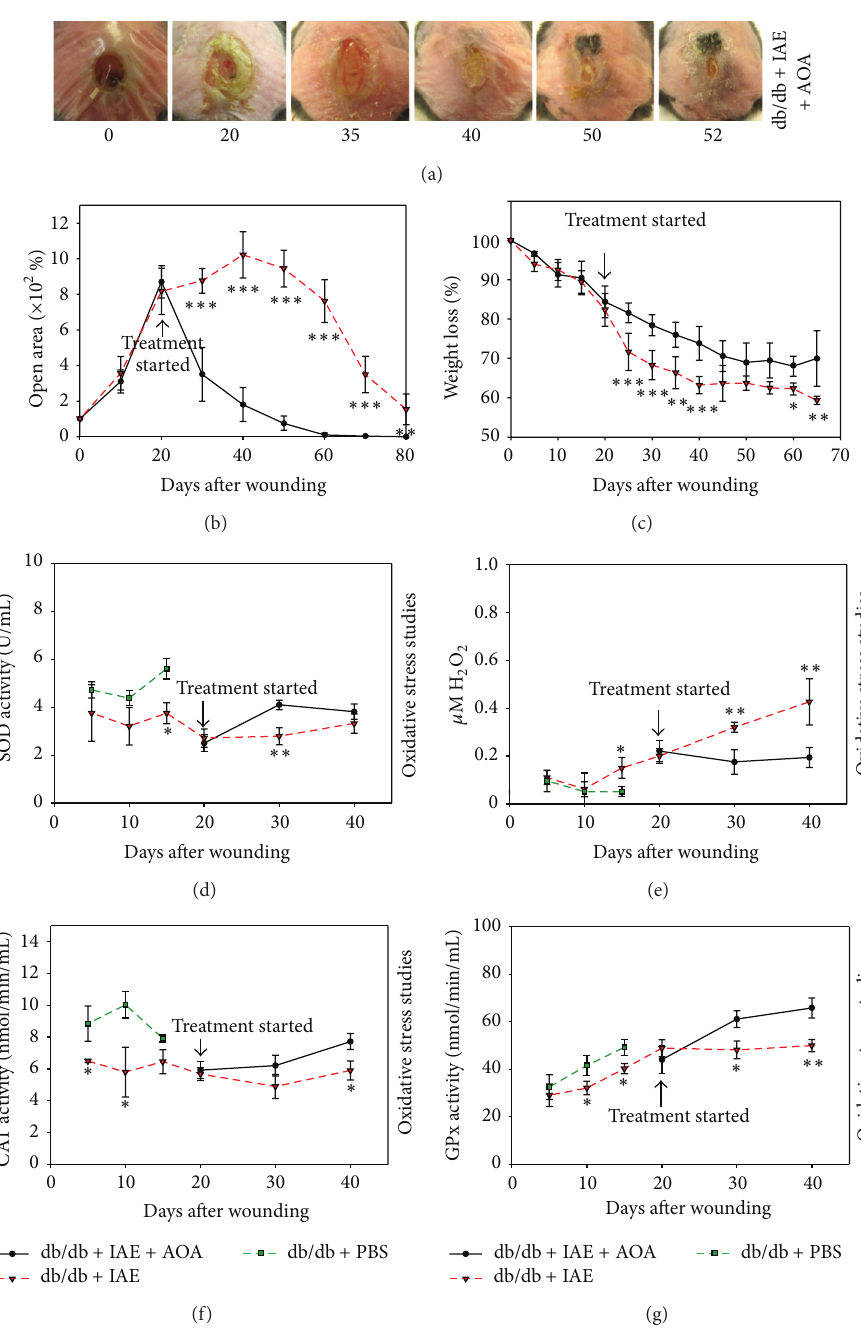
Figure 4: Treating chronic wounds with AOA leads to proper healing and reduced oxidative stress. (a) Chronic wounds of db/db mice treated with IAE and then AOA, NAC, and 𝛼 -toc, show a faster rate of wound closure. Wound areas were traced and analyzed using Image J. (b) Percent open wound area in db/db wounds treated with IAE and then AOA compared to db/db wounds treated with IAE alone. AOA significantly accelerated wound closure. (c) Weight loss was significantly higher in db/db mice treated with IAE alone than when treated with IAE and then AOA. (d) The levels of SOD in db/db wounds treated with PBS were significantly higher than db/db wounds treated with IAE suggesting that the latter have reduced dismutation of O 2∙− radicals and accumulation of reactive radicals. AOA treatment of chronic wounds significantly increased SOD activity 10 days after treatment suggesting increased dismutation of O 2 ∙− radicals. (e) Increases in H 2 O 2 levels (examined as described in Figure 1) in db/db wounds treated with AOA were stabilized in comparison to the increasing stress in the non-AOA treated wound. (f) Catalase activity was significantly increased in PBS treated wounds in the first 15 days as compared to the IAE treated wounds. AOA treatment of chronic db/db wounds significantly increased catalase activity by 20 days of treatment. (g) GPx in the db/db mice treated with PBS was significantly higher than the db/db mice treated with IAE. Enzyme activity in the db/db chronic wounds treated with AOA was significantly higher than db/db mice with only IAE. The overall effect was stabilized levels in H 2 O 2 . All data are mean ± SD. ∗ 𝑃 < 0.05 , ∗∗ 𝑃 < 0.01 . 𝑛 = 6 or 7 for each of the studies unless indicated